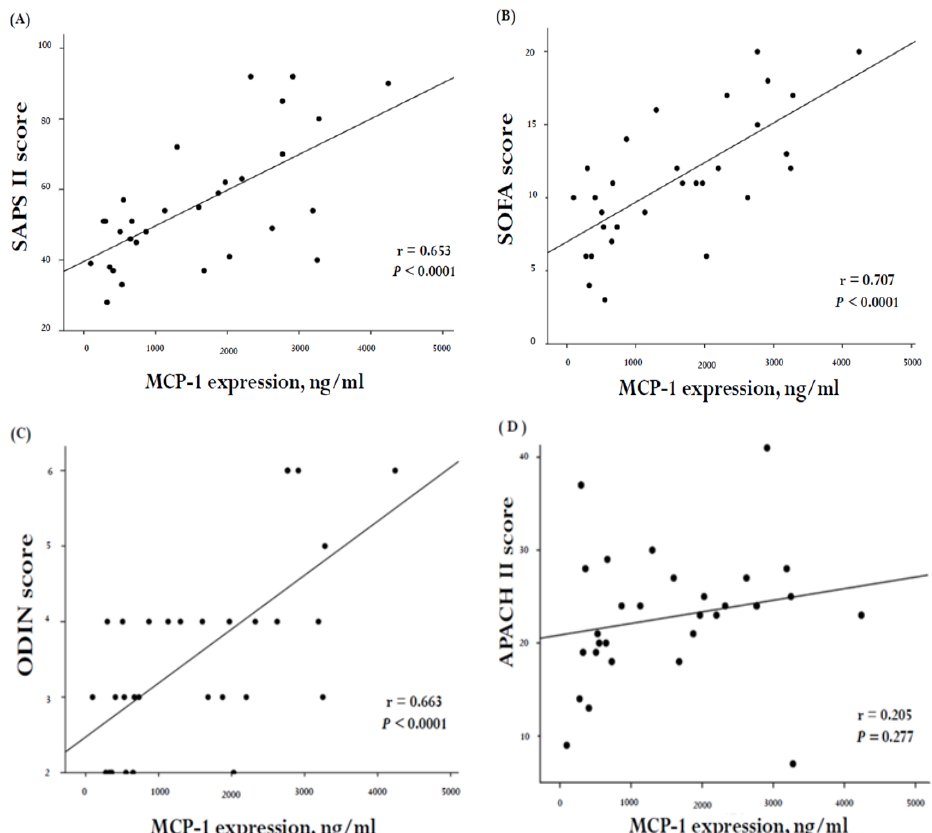
Figure 5. Correlation of plasma MCP-1 with severity of organ failure score (non-specifically for VAP) in 30 VAP subjects. There was a positive correlation between MCP-1 levels and ( A ) SAPSII (general linear model, r = 0.653, p < 0.0001, n = 30), ( B ) SOFA (general linear model, r = 0.707, p < 0.0001, n = 30), ( C ) ODIN (general linear model, r = 0.663, p < 0.0001, n = 30) and ( D ) APACH II (general linear model, r = 0.205, p = 0.277, n = 30)